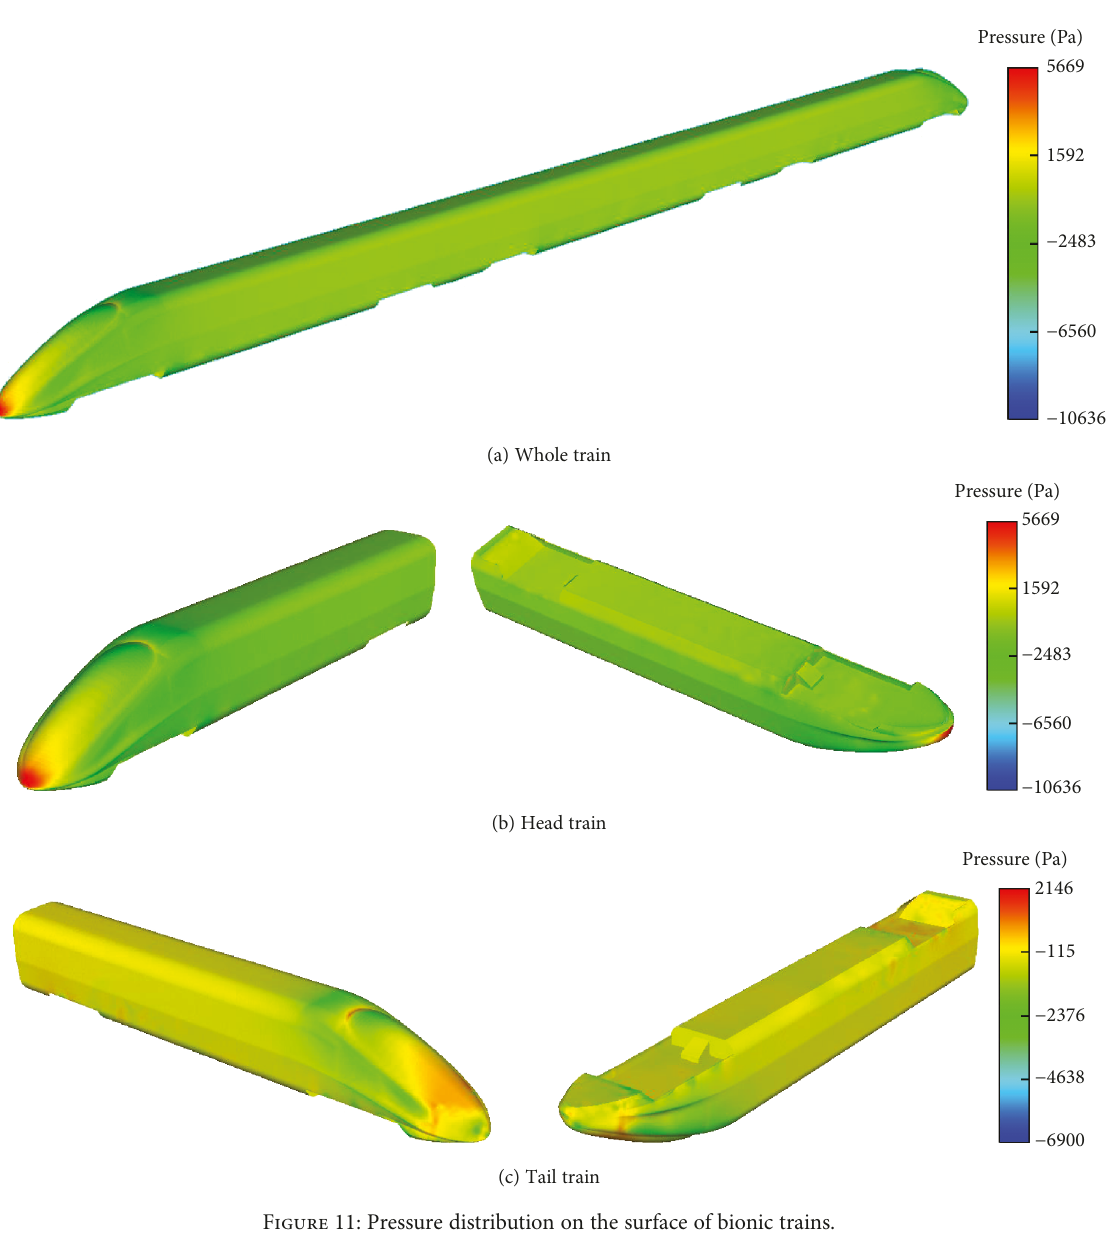
Figure 11: Pressure distribution on the surface of bionic